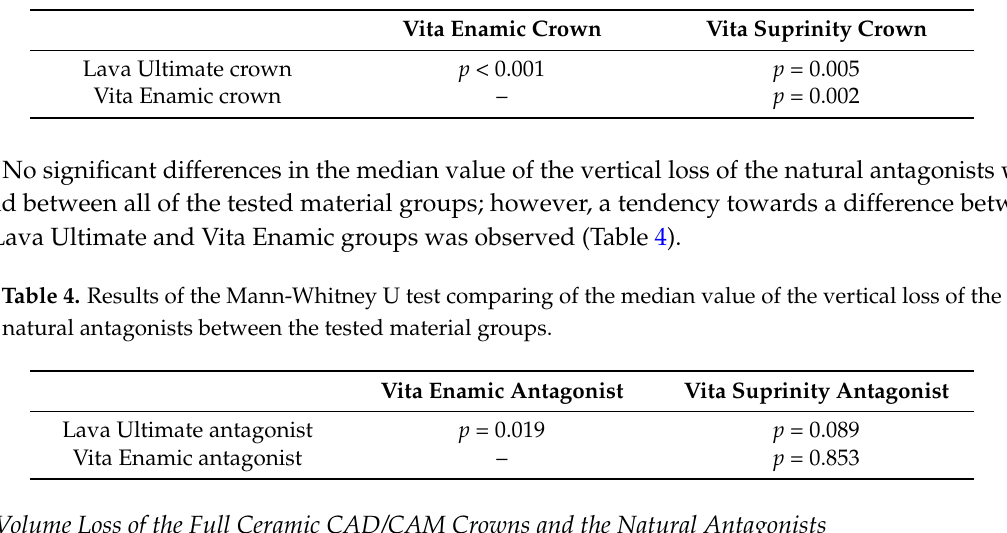
Table 3. Results of the Mann-Whitney U test comparing of the median value of the vertical loss of the full ceramic CAD/CAM crowns between the tested material groups. Vita Enamic Crown Vita Suprinity Crown Lava Ultimate crown p < 0.001 p = 0.005 Vita Enamic crown – p = 0.002 The vertical loss of the natural antagonists after 1,200,000 chewing cycles was found in the